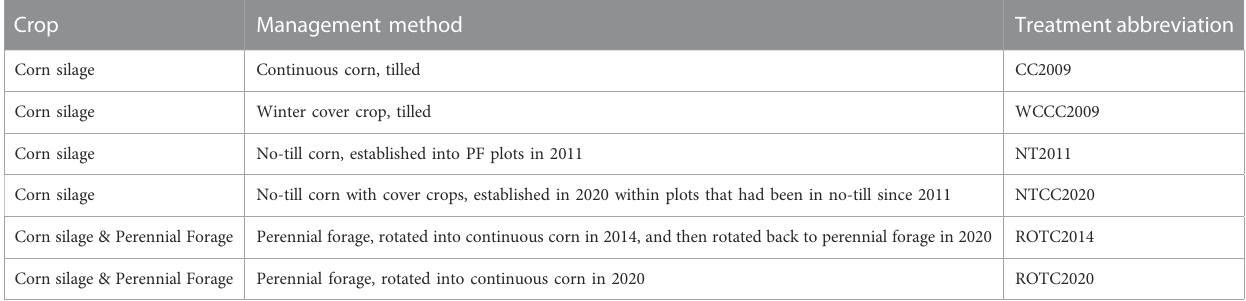
TABLE 1 Corn cropping system treatments evaluated for yield, forage quality and soil health in this study.